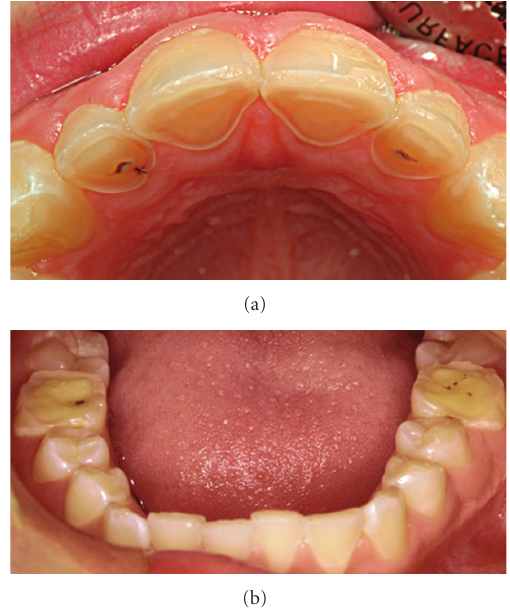
Figure 4: A 12-year-old boy who has a high intake of cola. (a) Note the severe damage with shoulder formations palatally on maxillary front teeth. (b) First molars also exhibit pronounced wear. Published with permission from the Journal of the Swedish Dental Association (Tandl¨akartidningen) [12].